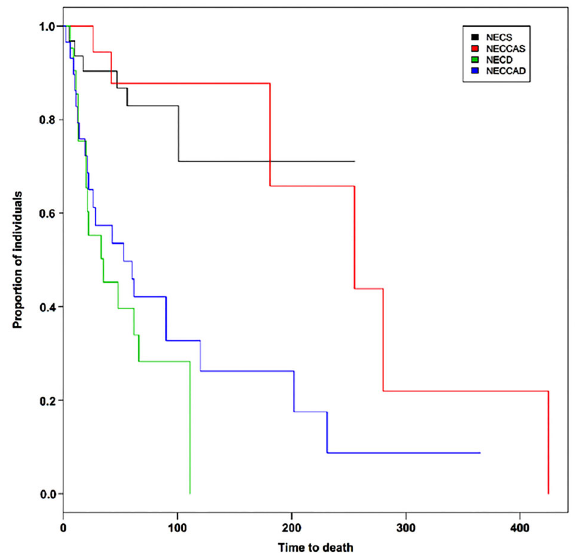
Figure 1. Time to death (days) in the groups according to the presence of heart disease and type of surgical treatment. CHD: congenital heart disease; NECS: necrotizing enterocolitis (NEC) patients undergoing surgery; NECD: NEC patients undergoing peritoneal drainage; NECCAS: NEC + CHD patients undergoing surgery; NECCAD: NEC + CHD patients who were drained.